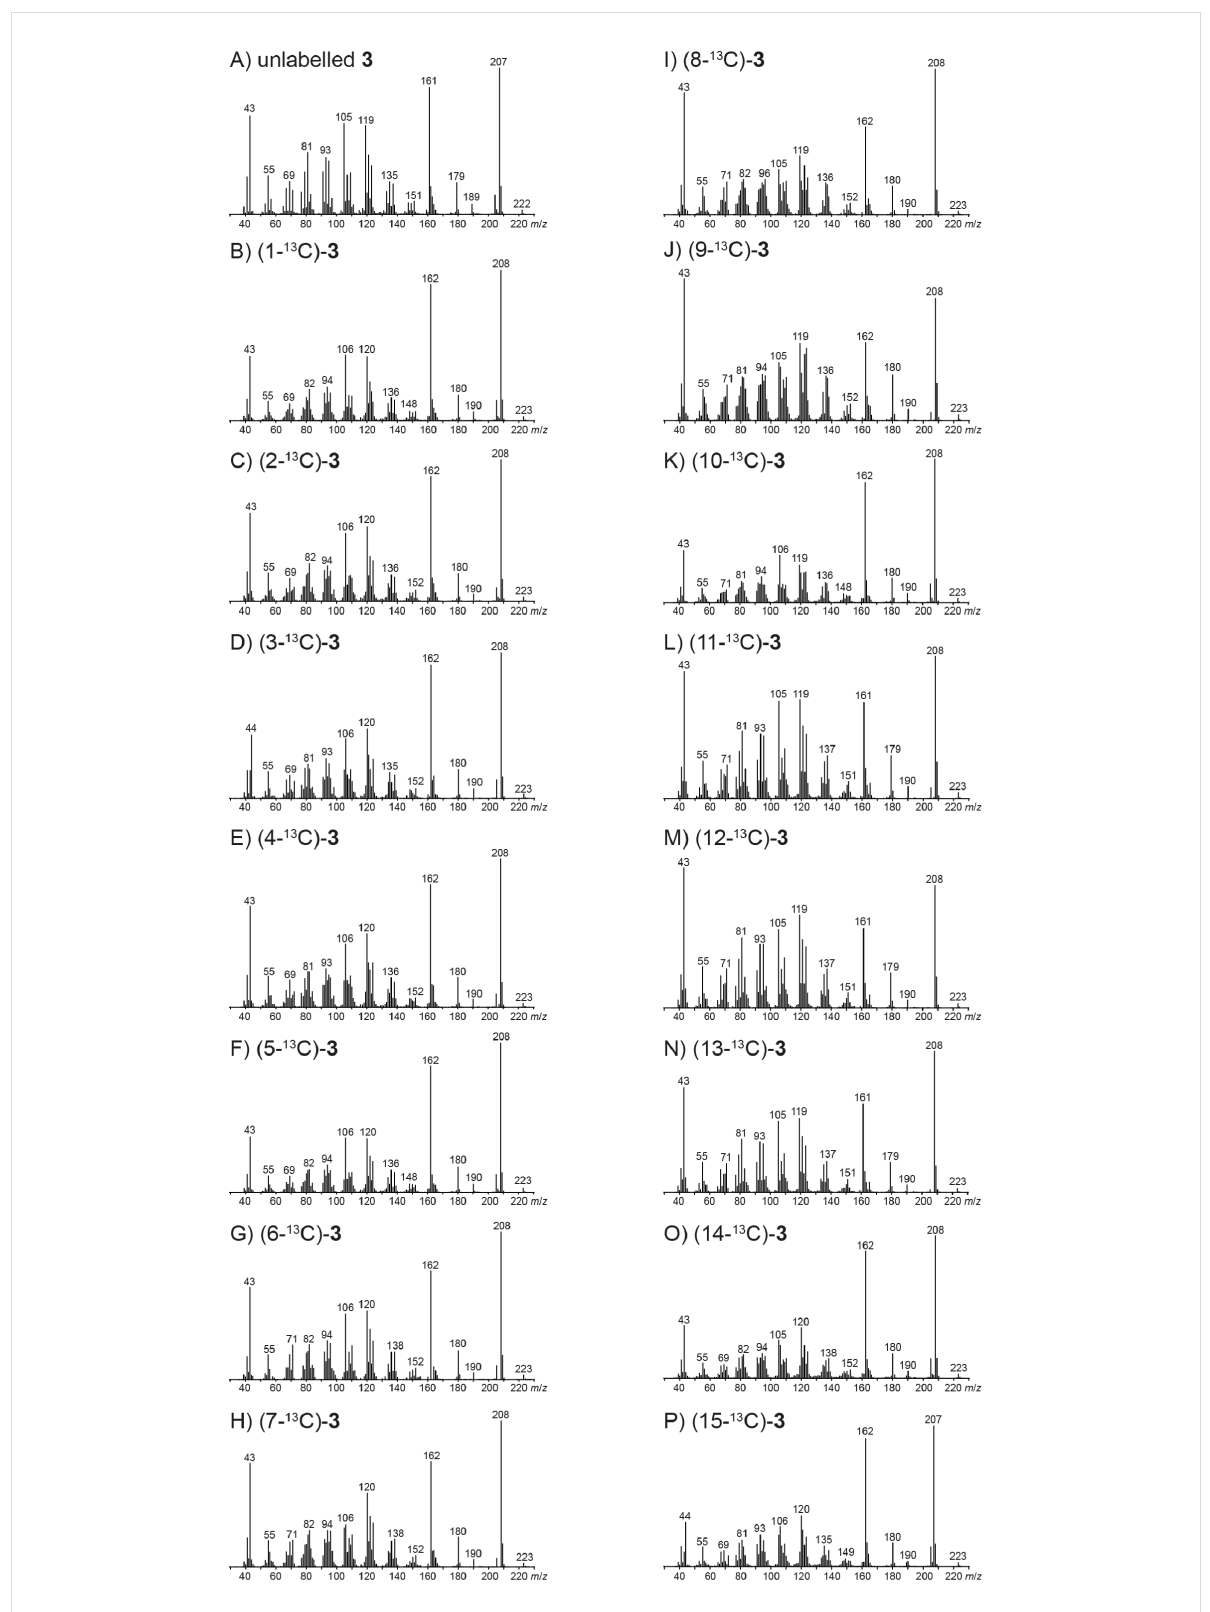
Figure 3: Mass spectra of unlabelled 3 and all fifteen positional isomers of ( 13 C 1 )- 3